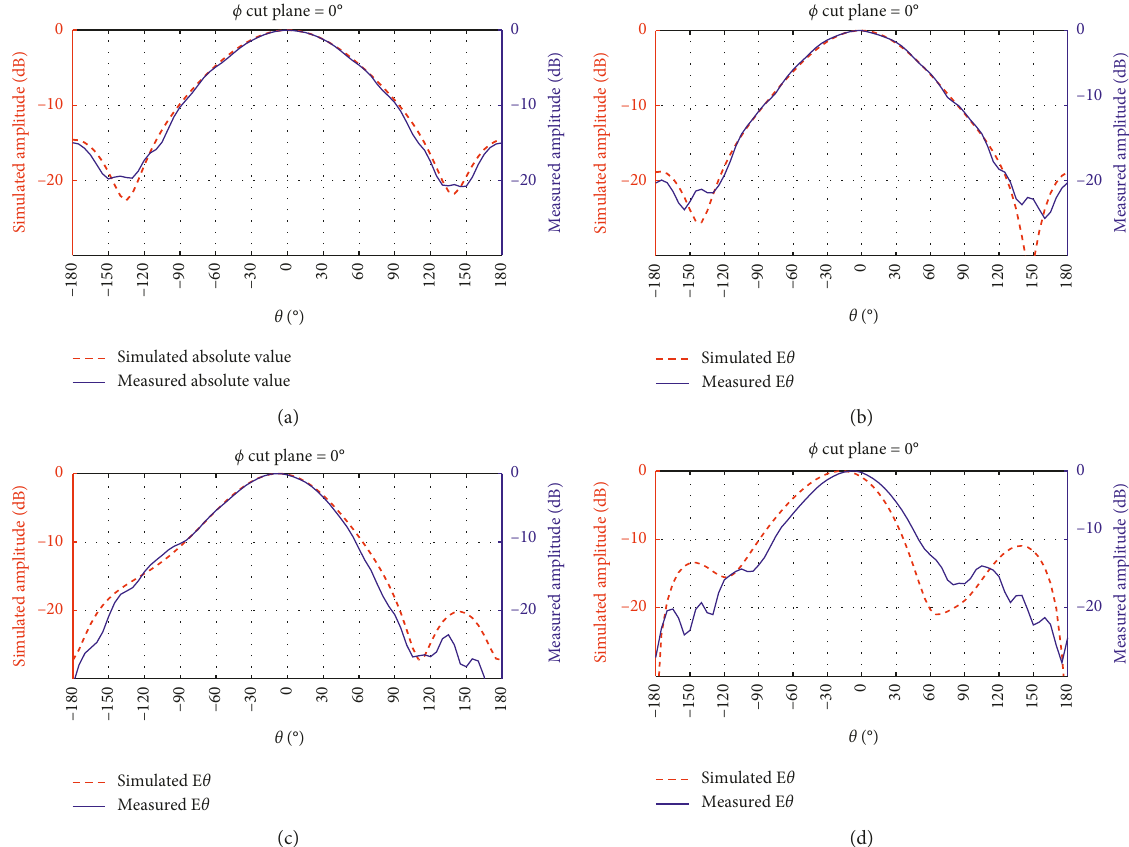
Figure 13: Simulation and measurement of the far-field antenna gain (E-plane) at different frequencies: (a) f � 1GHz, (b) f � 1.25GHz, (c) f � 1.4GHz, and (d) f �